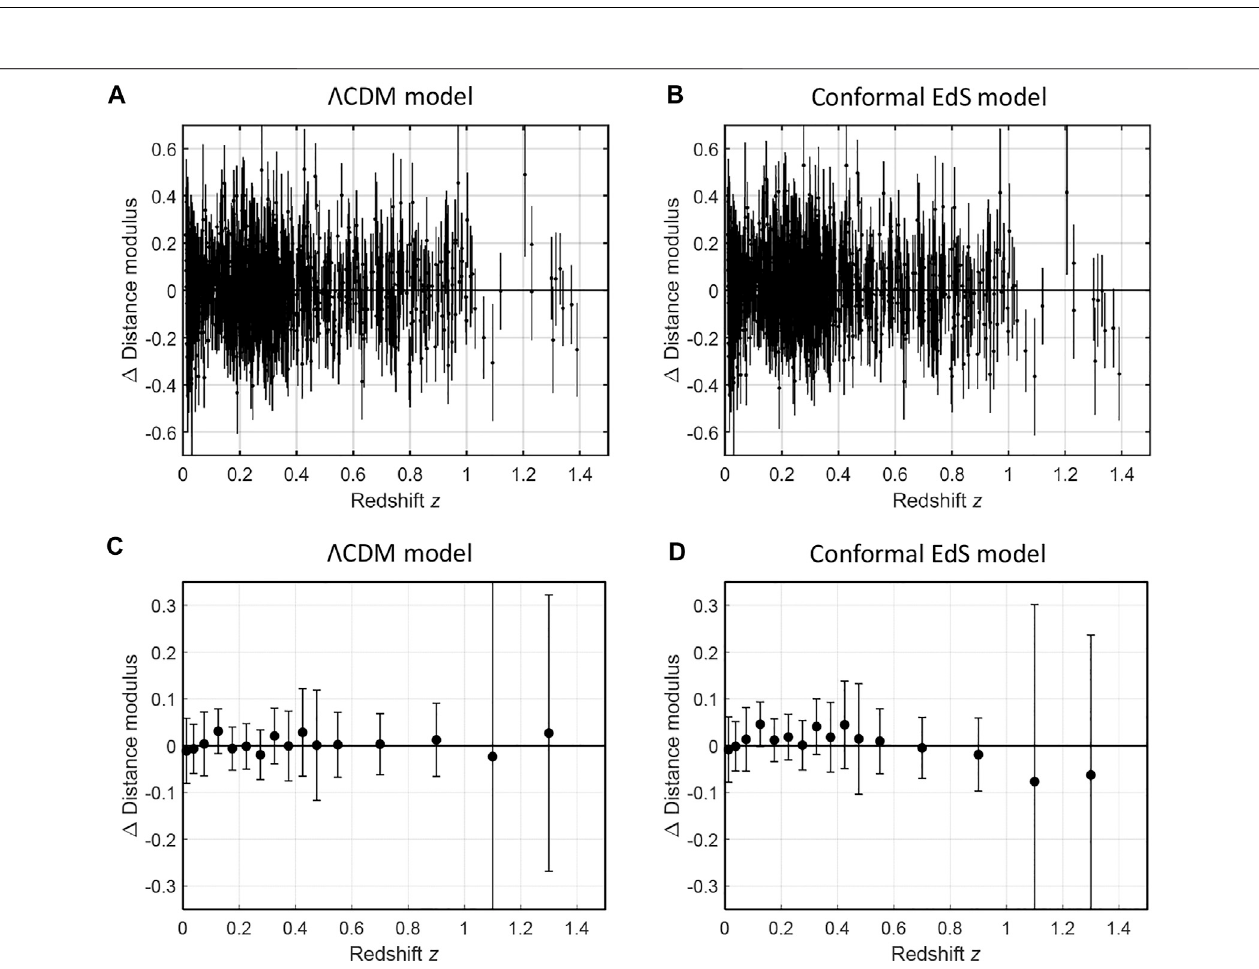
FIGURE 2 | Residual Hubble plots for (A,B) the individual SNe Ia data and (C,D) the binned SNe Ia data. (A,C) The fl at Λ CDM model, (B,D) the conformal EdS model. For parameters of the models, see caption of Figure 1 . The error bars in (C,D) show the 99% con fi dence intervals. Data are taken from the SNe Pantheon compilation [45,